Question: Sum up the contents of this chart in one sentence.
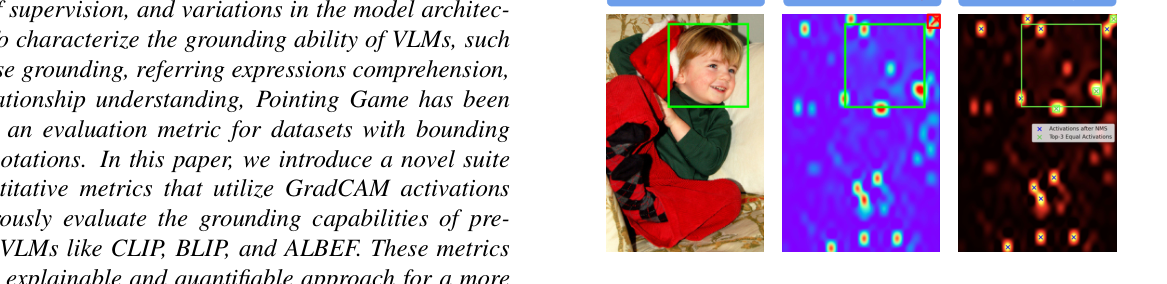
Answer: Uncertainty in Pointing Game (PG) accuracy, when hav- ing multiple top-k identical activations with inconsistent PG binary labels (Scenario 1). As depicted in the bottom-right figure, three top high-confidence activations exist, each with a value of 1.0, after our NMS analysis. One falls outside the bounding box, one inside, and one at the border. In these cases, PG lacks any addi- tional clues or heuristics to determine which one to select.